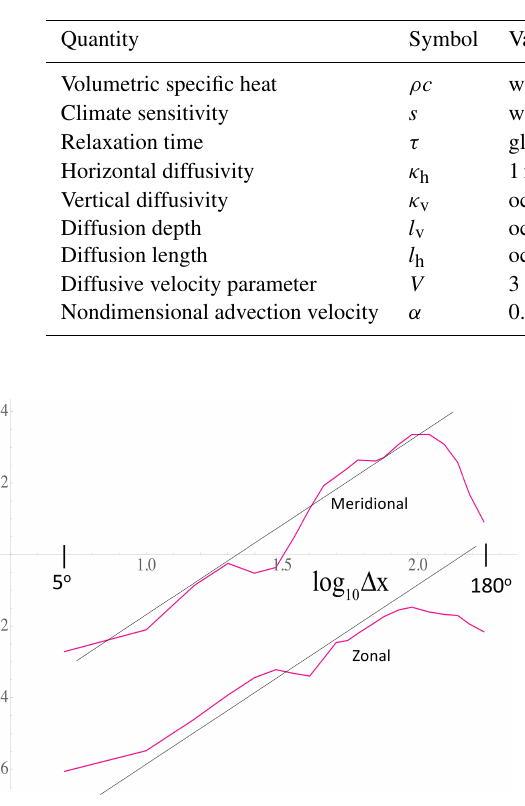
Figure A1. The rms fluctuations (at (cid:49)t = 1 month resolution) (cid:49) log s (cid:49)t ( (cid:49)x ) (zonal, bottom) and (cid:49) log s (cid:49)t ( (cid:49)y ) (meridional, top) from NCAR reanalyses. The vertical scale is dimensionless, and the horizontal scale is in log 10 (degrees) with the minimum (5 ◦ ) and maximum (180 ◦ ) indicated in large, bold font. The black lines are reference lines (not regressions) with slopes H x = H y =